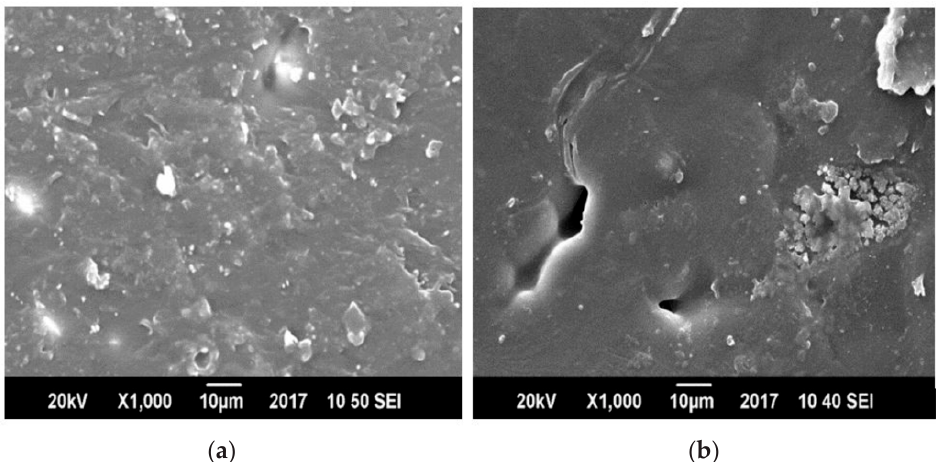
Figure 11. SEM images of ( a ) MAH ‐ g ‐ PP/PP/PET and ( b ) MAH ‐ g ‐ PP/PP/PET blends with composition 2.5/37.5/60 and 5/35/60, respectively.